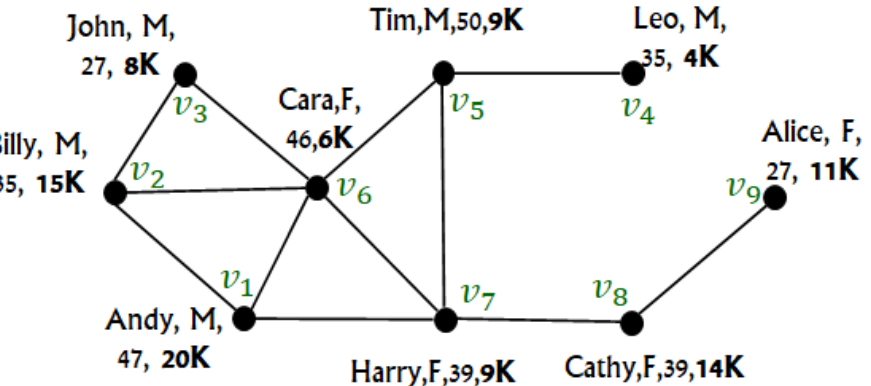
Figure 1. Overview of SN data (friends network) modeling/representation with G